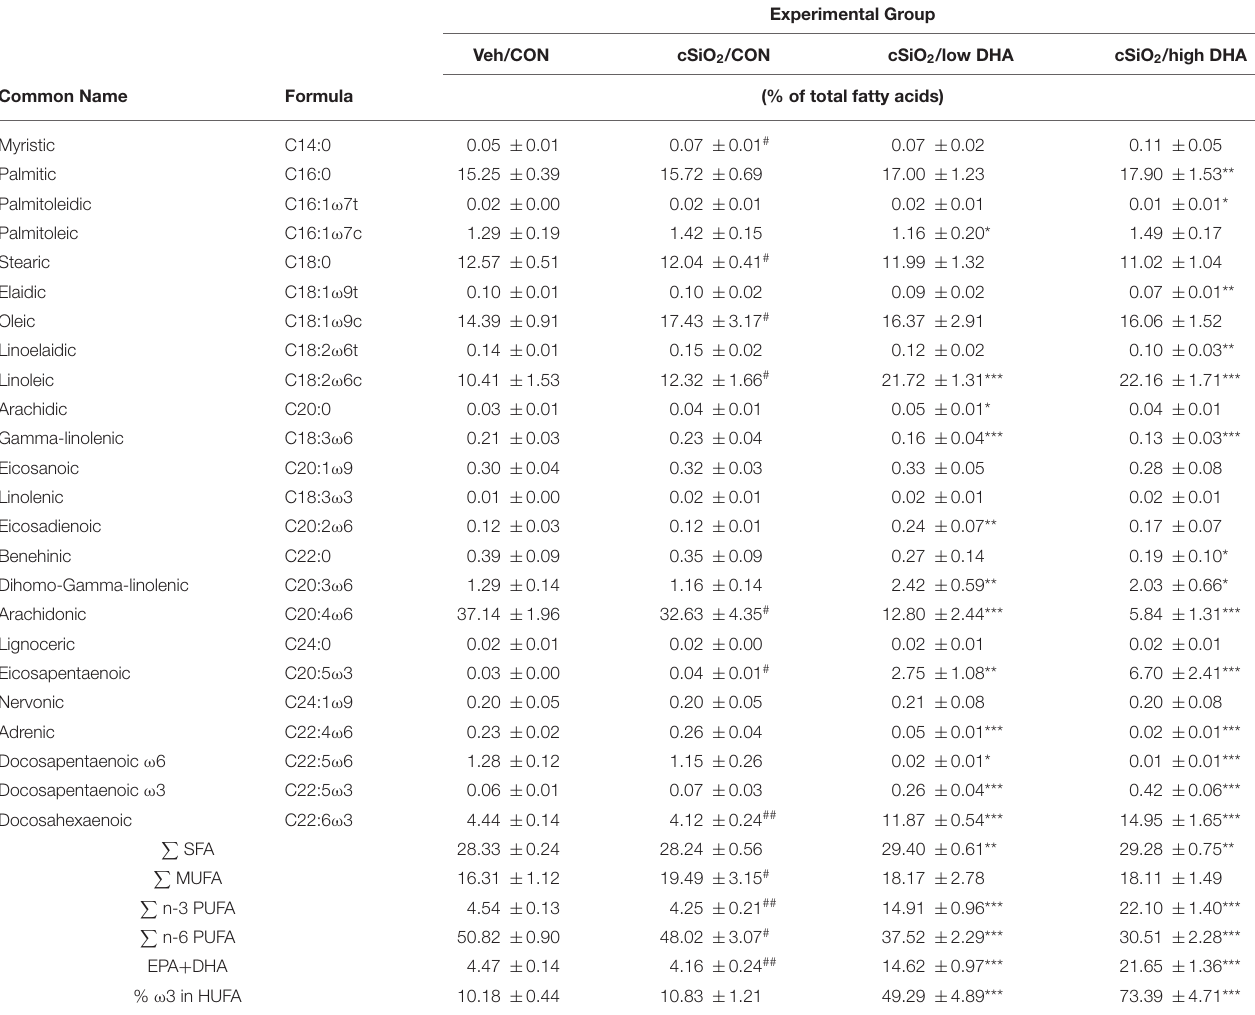
TABLE 3 | Plasma fatty acid content of experimental groups.